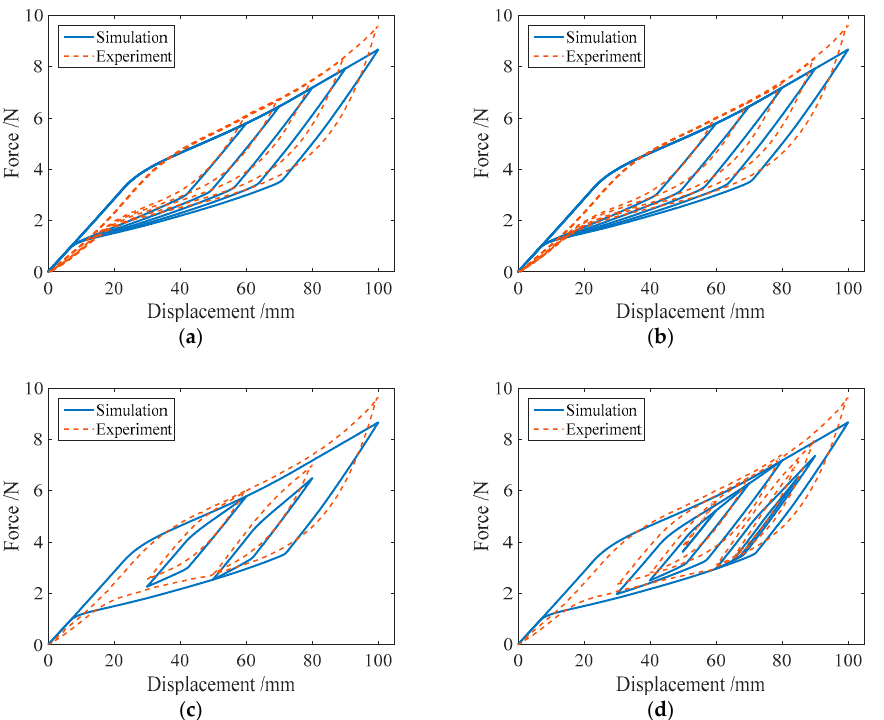
Figure 13. The simulation results of the force-displacement relationship of specimen SMA-S3 in